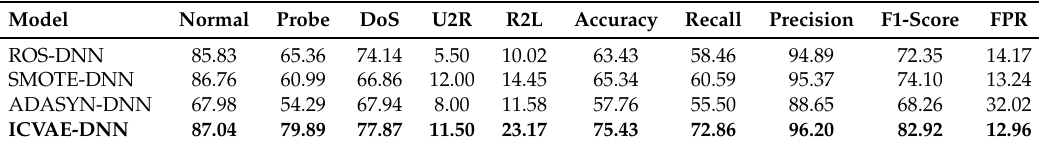
Table 7. Comparison of detection performance for different oversampling methods on the NSL-KDD (KDDTest-21) data set (%).